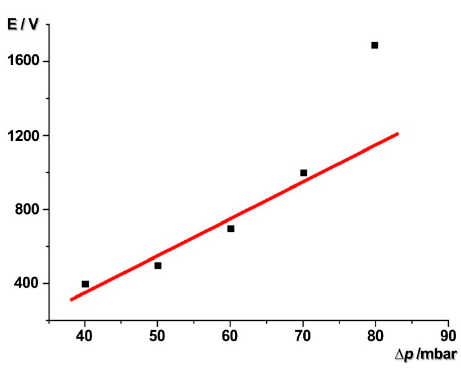
Figure 5. The minimum electric potential applied on the system to stop the particle under different external pressure.